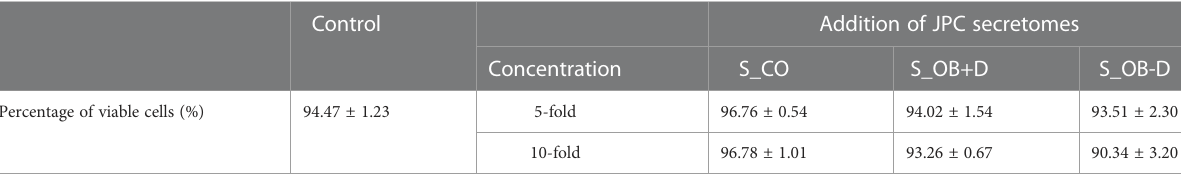
TABLE 4 Percentages of viable DCs generated in the presence of JPC